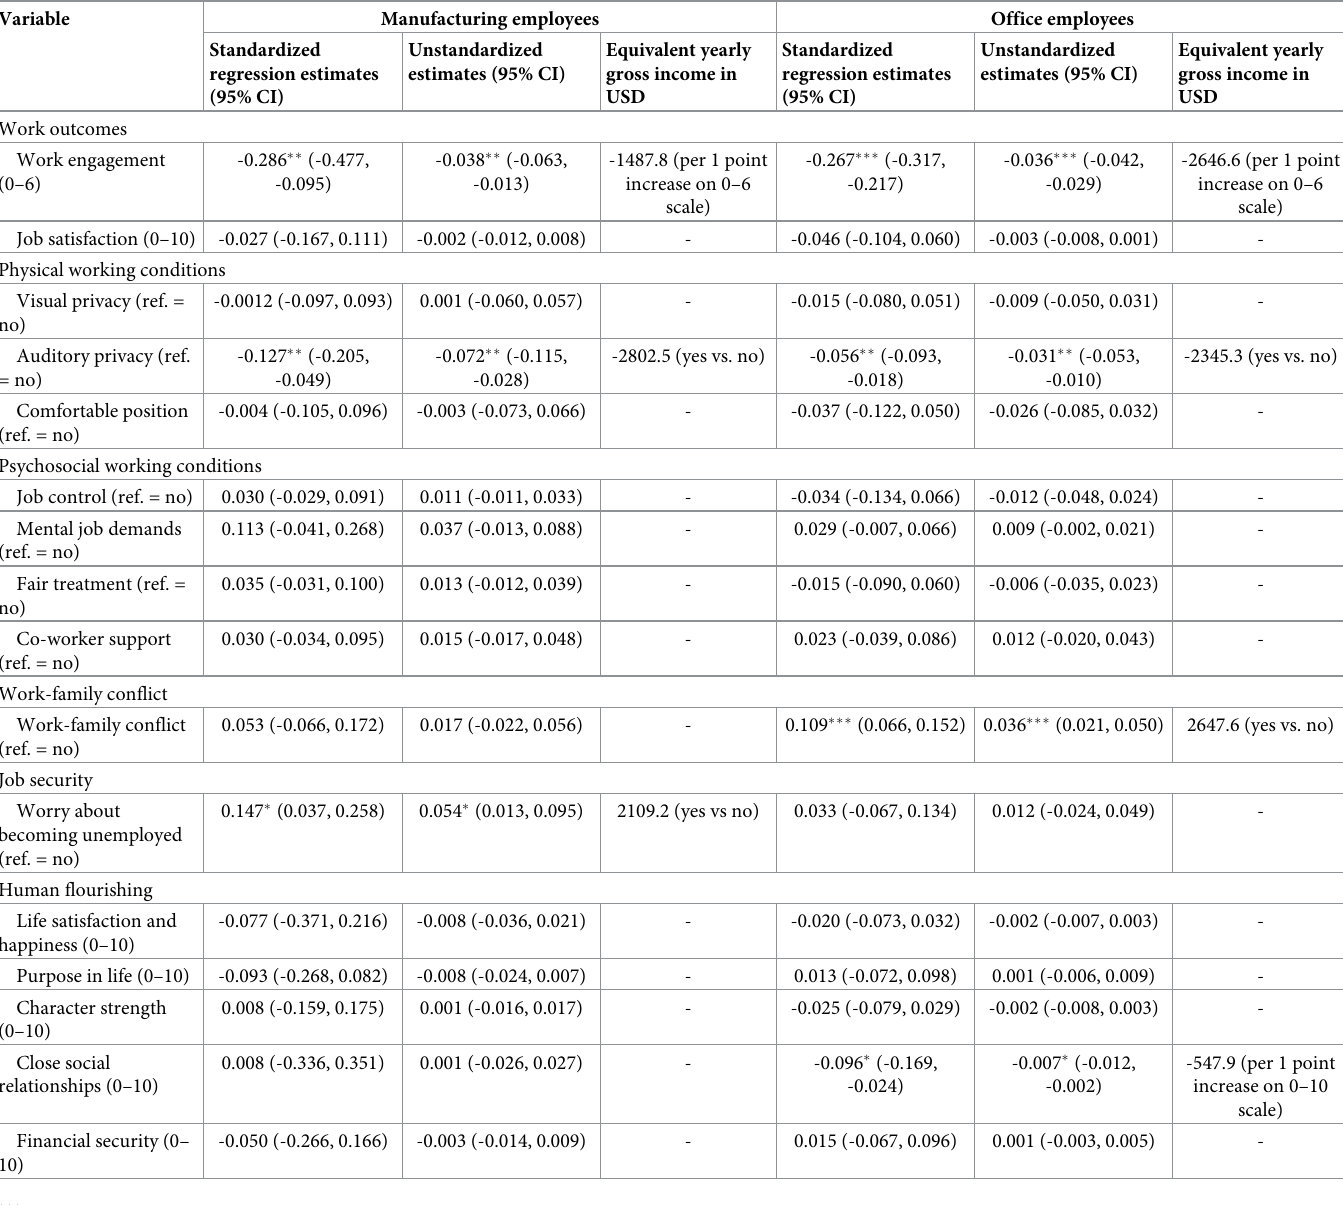
Table 4. Contribution to productivity loss and cost of productivity loss at the organizational level–primary analysis of a US manufacturing